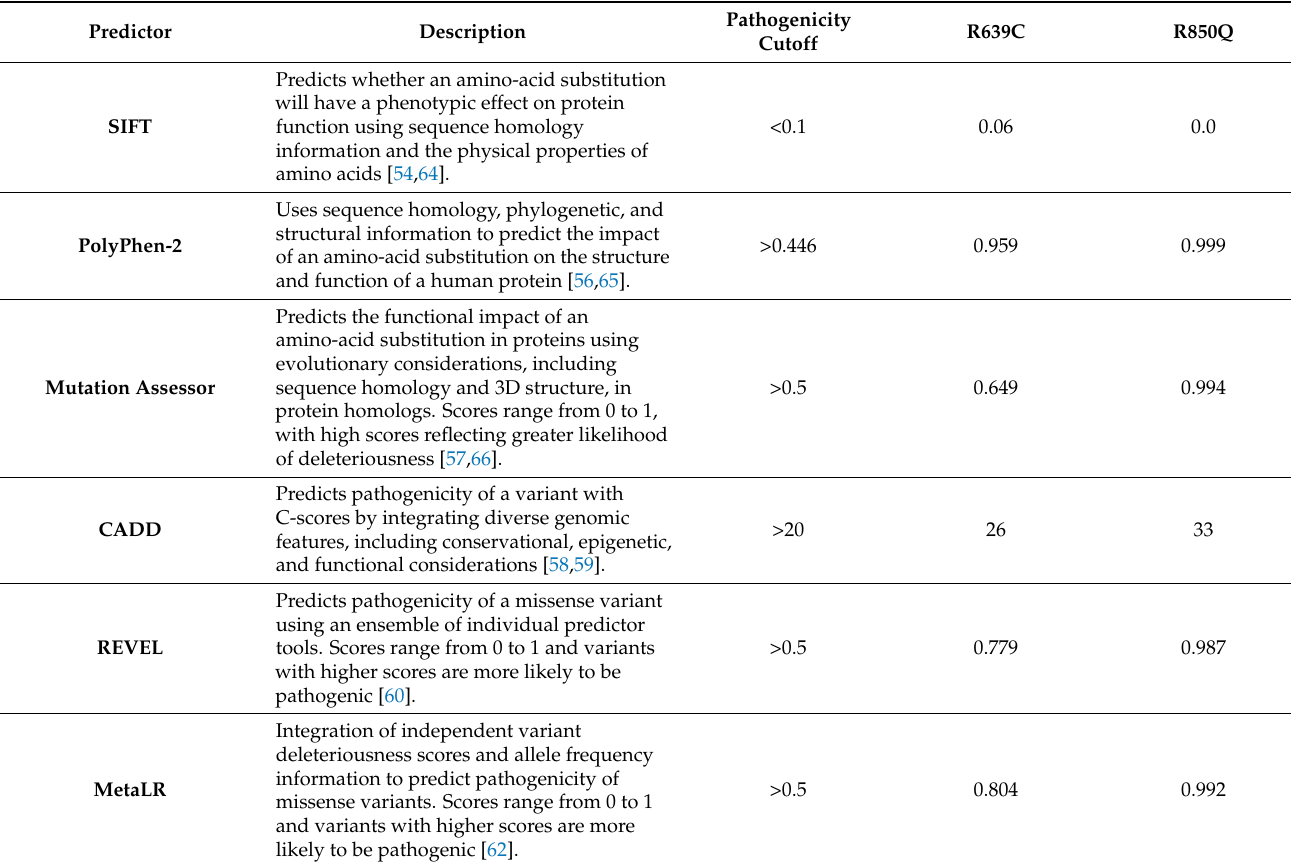
Table 1. Pathogenicity predictions for mutant Nav1.6 channels. Brief description of prediction algo- rithm tools used to predict deleteriousness/pathogenicity of mutant SCN8A channels and includes scoring information for each predictor. The SCN8A transcript LRG1389 was used as a reference. Pathogenicity Predictor Description R639C R850Q Cutoff